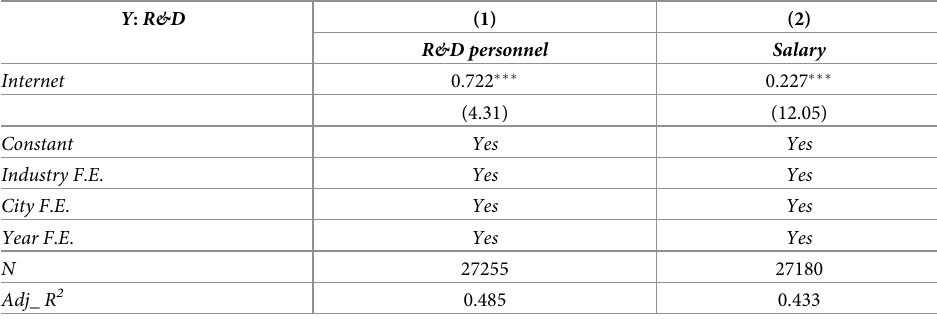
Table 7. Internet penetration and human capital.